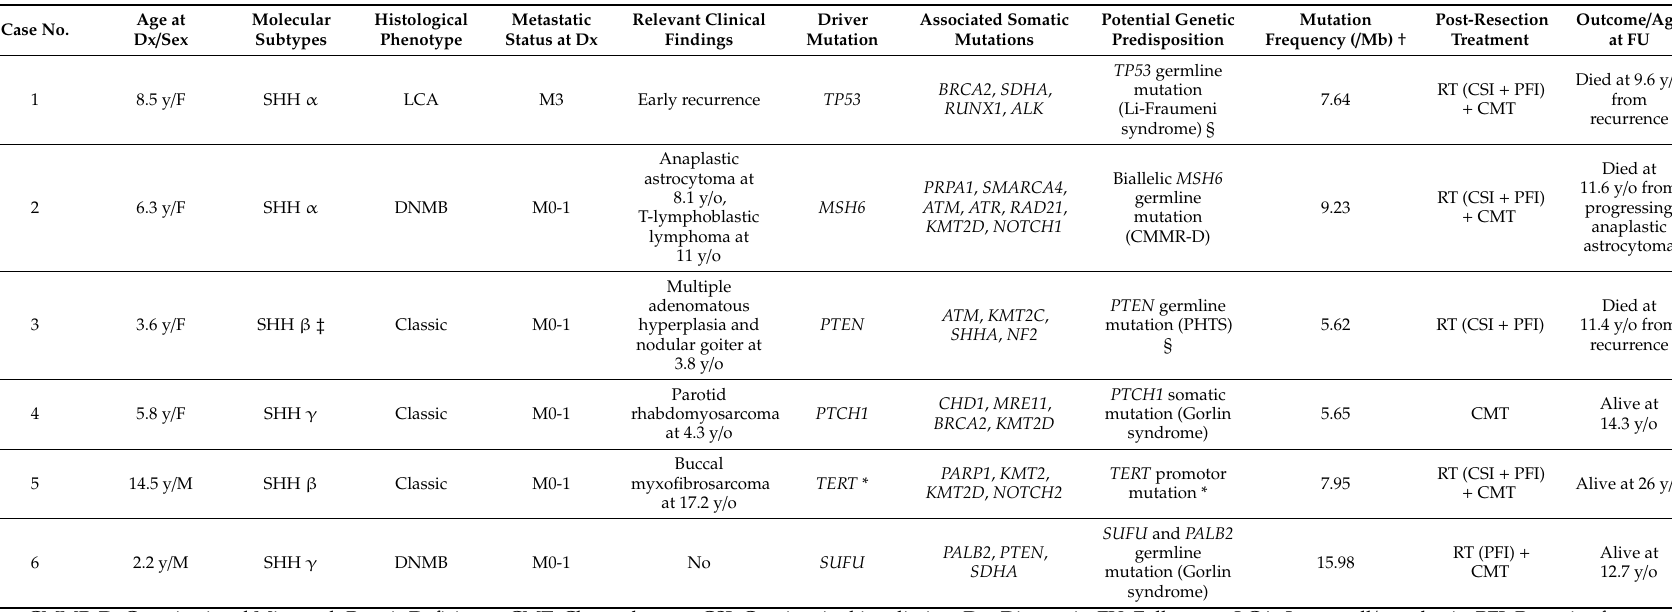
Table 4. Clinical parameters, relevant clinical findings, driver mutation, associated somatic mutations, potential genetic predisposition, and mutation frequency in six of ten SHH MBs with WES studies among seventeen SHH MBs in a cohort series of 52 childhood MBs in Taiwan. Case